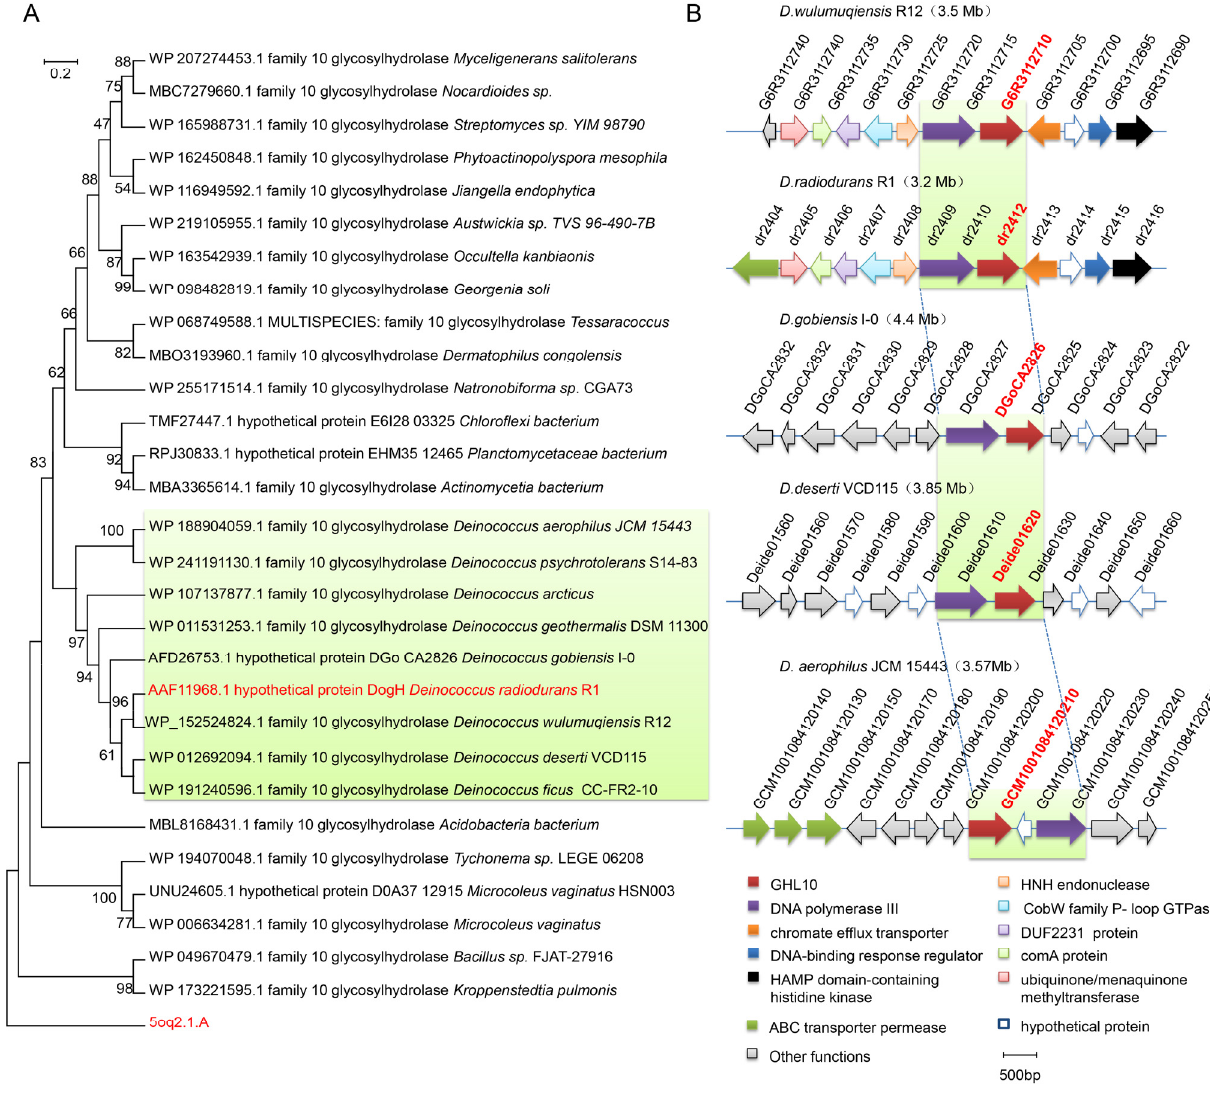
Figure 2. Phylogenetic analysis of DogH proteins and physical organization comparative analysis of gene clusters compared with other Deinococcus . ( A ) Neighbor joining tree method was used to compute the distances of DogH proteins using the MEGA 7.0 program. The D. radiodurans DogH protein and the 5oq2.1.A protein from uncultured bacteria are indicated with red font. ( B ) The gene organization of dogH homologous sequences in different Deinococcus species. D. wulumuqiensis R12; D. radiodurans R1; D. gobiensis I-0; D.deserti VCD115; D. aerophilus JCM15443. Same colors indicate similar predicted functions of the depicted ORF. Orthologous genes of dogH are shown in red. Orthologous genes of dr2410 and dr2413 are shown in purple and orange, respectively. Adjacent genes are labeled with other colors. The genome size is indicated at the end of the physical organization.